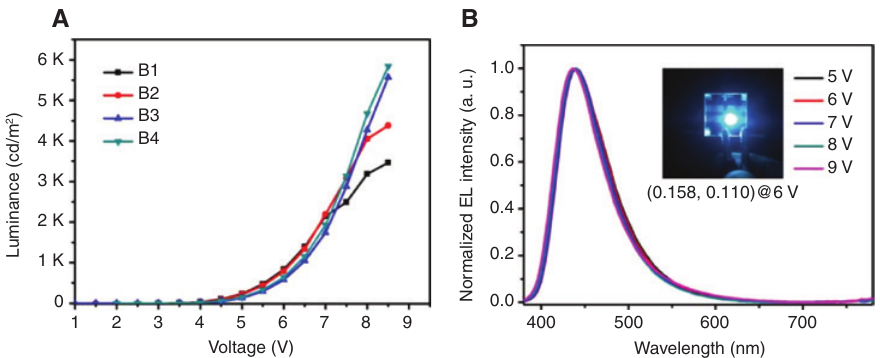
-based blue devices; (B) Normalized EL spectra of device B3 at different voltages, Inset: A 2